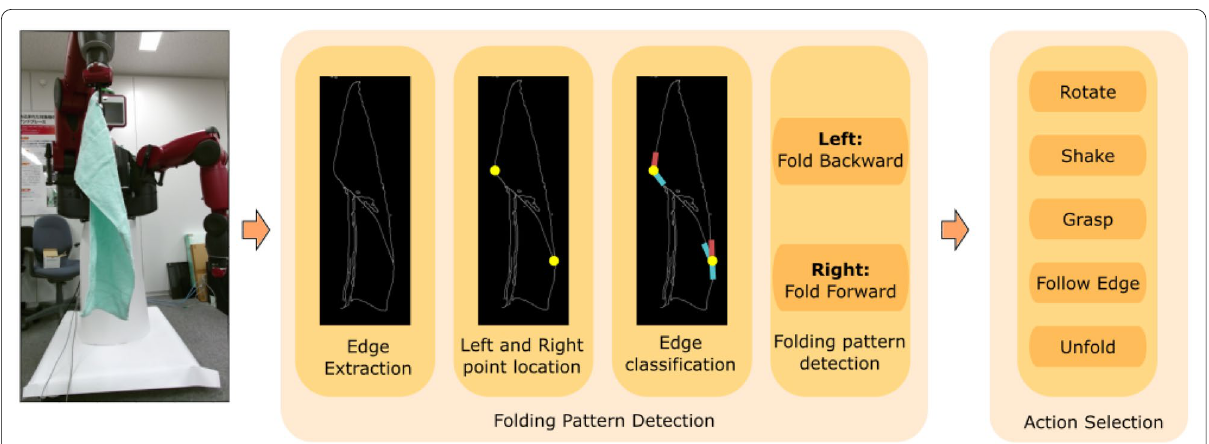
Fig. 7 Sequence of processes for unfolding. First, the edges are extracted from a depth image. Then leftmost and rightmost points are located and classified. According to the type of folding pattern, an action is selected and executed by the robot